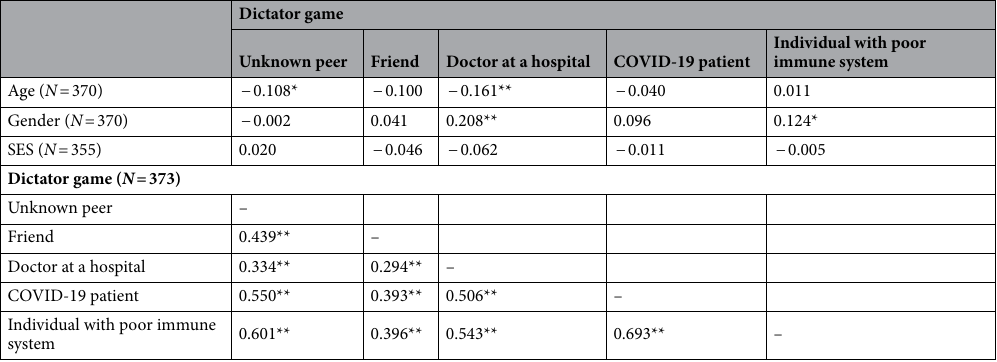
Table 4. Bivariate correlations among all variables used in the statistical analyses (at T3). * p < 0.05, ** p < 0.01.